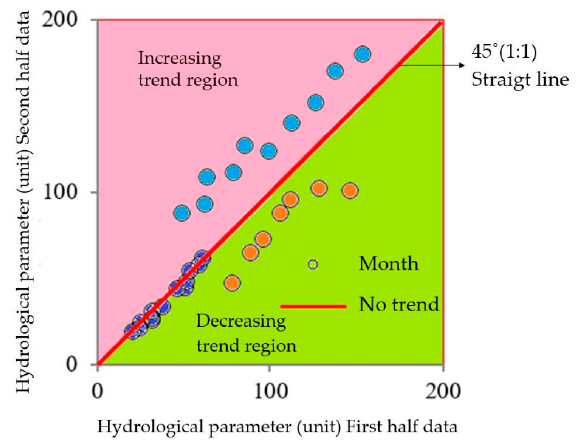
Figure 2. Decreasing and increasing trends versus trend-free time series [16].